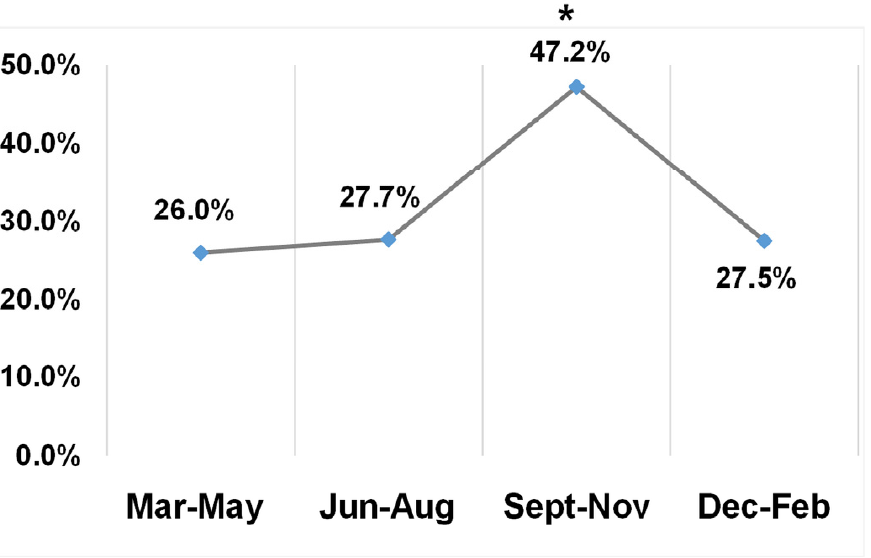
Figure 2. The prevalence of SFTSV RNA in ruminant samples in each season. The four seasons were